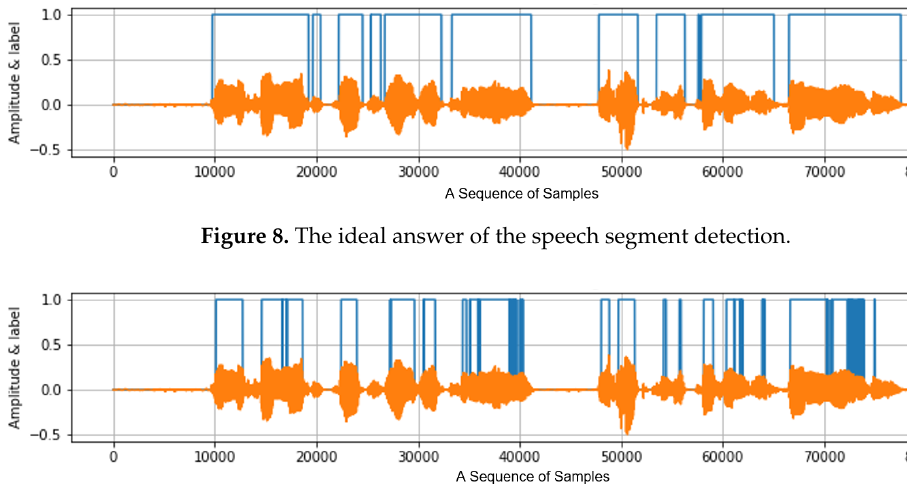
Figure 9. The result of energy-based